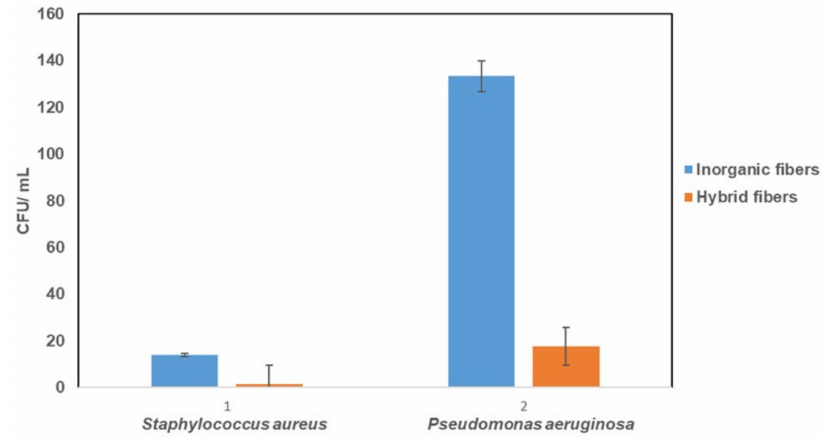
Figure 5. Comparison of the antibacterial activity for pure inorganic SiO 2 fibres and hybrid DACHsilane fibres against S. aureus and P. aeruginosa